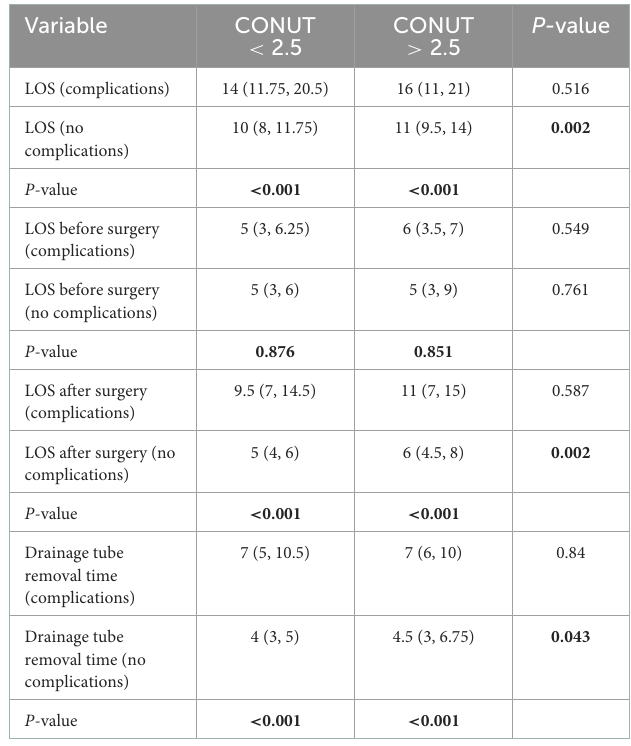
TABLE 6 Subgroup analysis of the relationship between CONUT score, postoperative complications, length of hospital stay, and length of chest tube